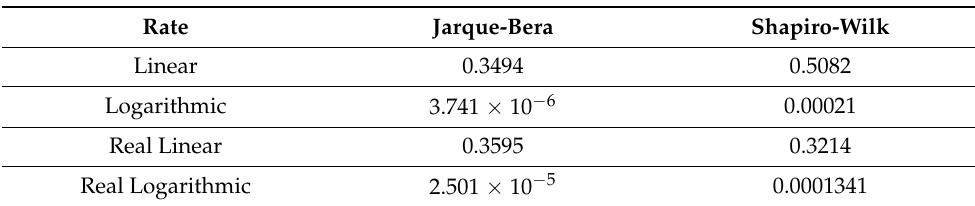
Table 3. Annual rates of p